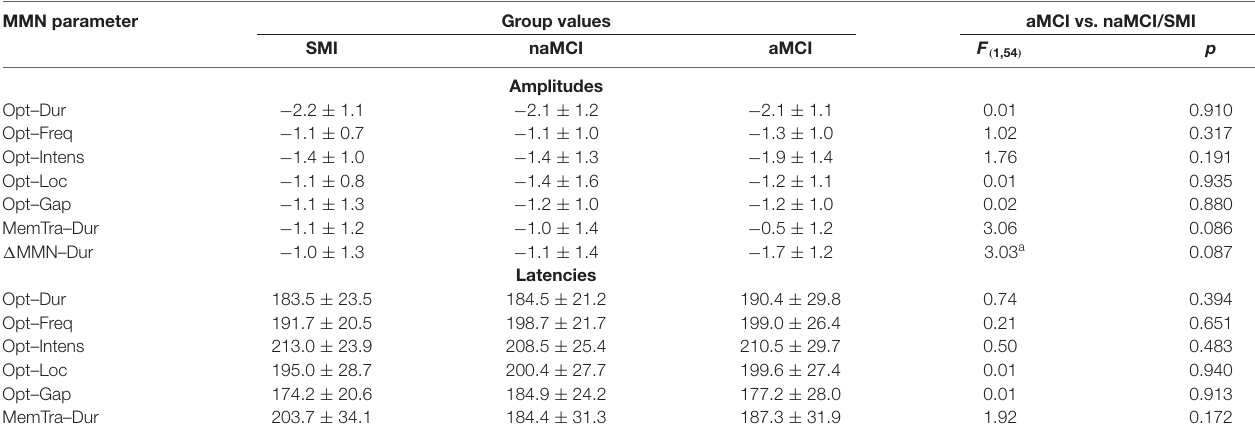
TABLE 2 | Mean MMN amplitudes and latencies within groups.